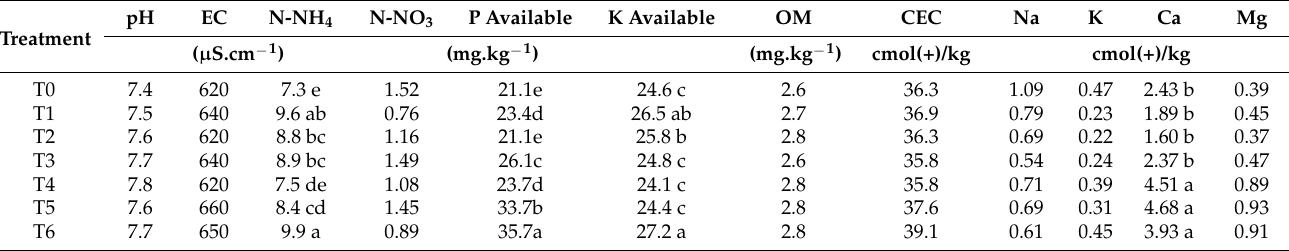
Table 7. Properties of the soil after harvesting in the experiment.